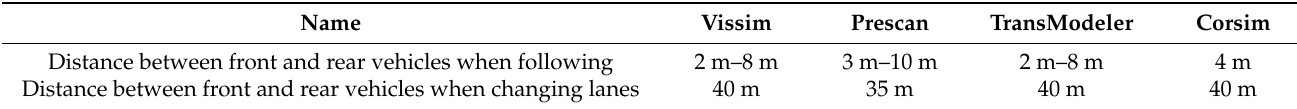
Table 6. Compare the model spacing in different simulation